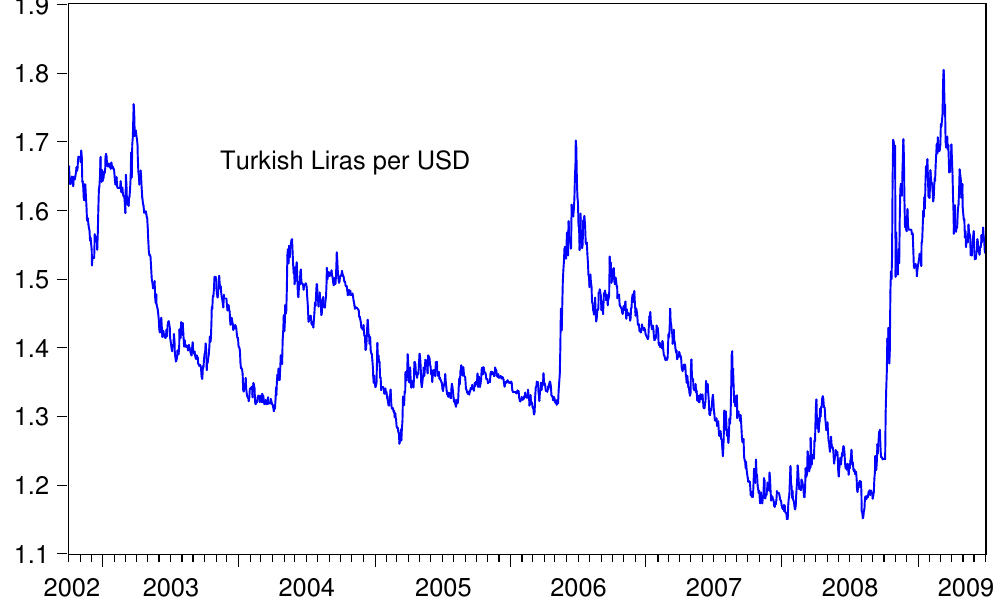
Figure 7. Turkish lira to USD exchange